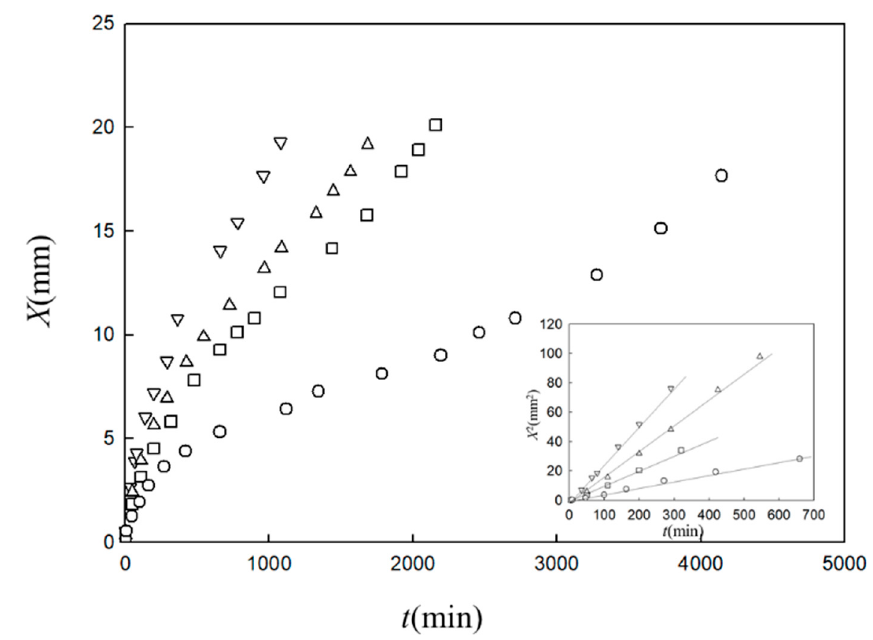
Figure 2. Time course of gel thickness X observed for one-dimensional growth of chitosan gel induced in 2 wt. % chitosan in 2 wt. % acetic acid aqueous solution in contact with sodium hydroxide aqueous solution with concentrations of 0.1 M (circles), 0.3 M (squares), 0.5 M (upward triangles) and 1 M (downward triangles) [25]. The inset shows the X 2 vs. t plot.